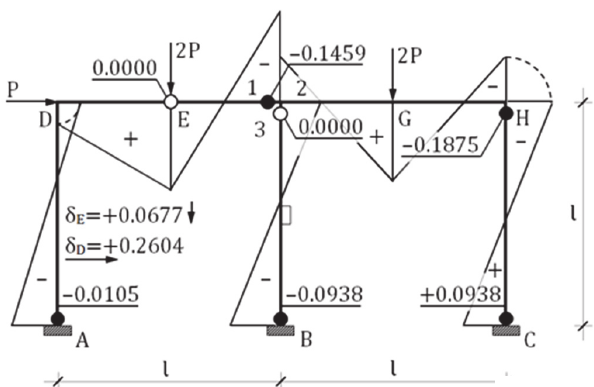
Figure 5: Collapse kinematic